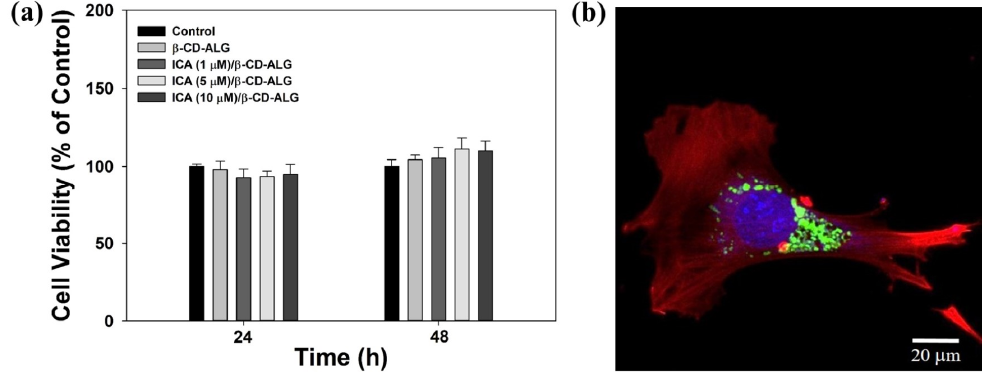
Figure 5. ( a ) Cytotoxicity test of β-CD-ALG, ICA (1  M)/β-CD-ALG, ICA (5  M)/β-CD-ALG, and ICA (10 µ M) / β -CD-ALG on MC3T3-E1 cells. ( b ) Cellular uptake of FITC / β -CD-ALG after incubation of 8 h. (10  M)/β-CD-ALG on MC3T3-E1 cells. ( b ) Cellular uptake of FITC/β-CD-ALG after incubation of 8 Scale bar: 20 µ h. Scale bar: 20  m.